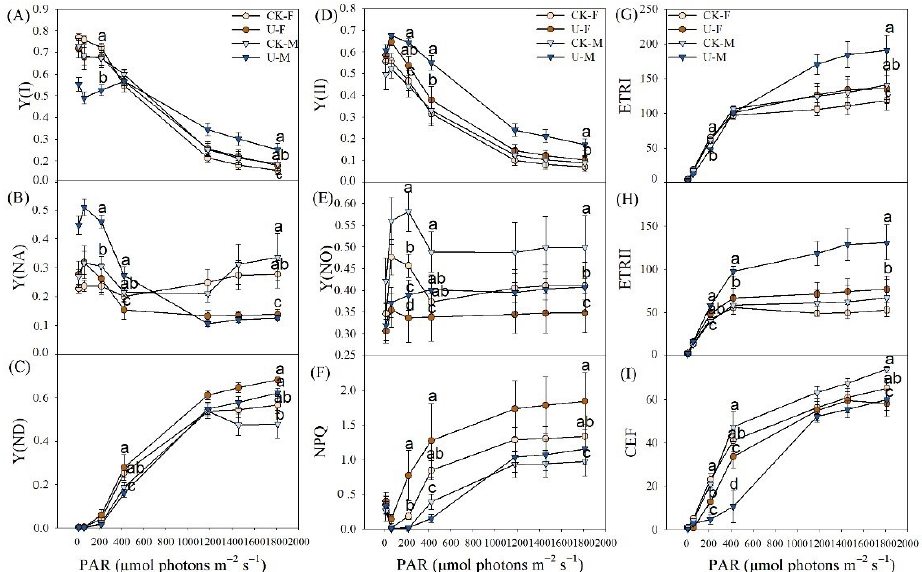
Figure 3. Effect of sexuality on rapid light induction curve of P. cathayana under U stress: effects on Y(I) ( A ), Y(NA) ( B ), Y(ND) ( C ), Y(II) ( D ), Y(NO) ( E ), NPQ ( F ), ETRI ( G ), ETRII ( H ) and CEF ( I ). Values are expressed as means ± SE ( n = 3). Different letters represent significant differences between treatments ( p < 0.05).